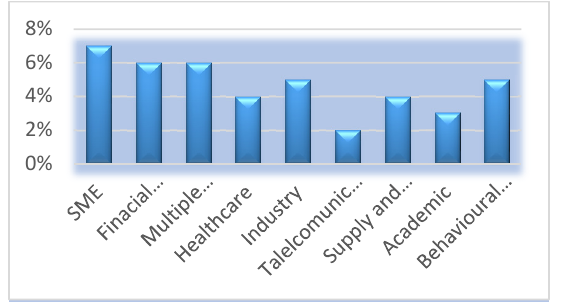
Fig. 3: Sector-wise distribution of articles